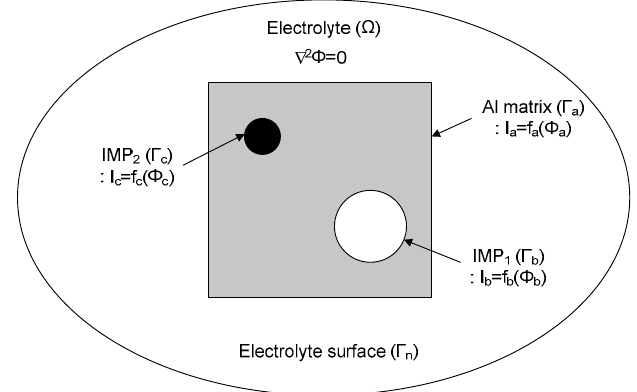
Figure 1. Boundary conditions for corrosion simulation of intermetallic particles (IMPs) in an aluminum matrix.